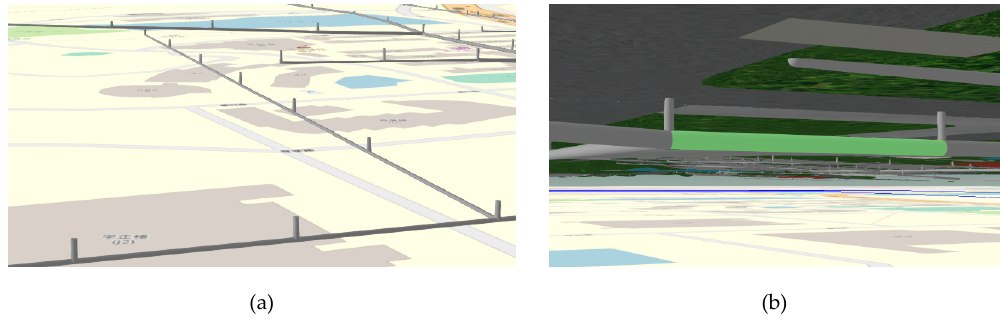
Figure 18. 3D drainage pipeline system in the study area: (a) Visualization of 3D drainage pipeline system alone; (b) 3D virtual environment of the study area from the underground perspective.